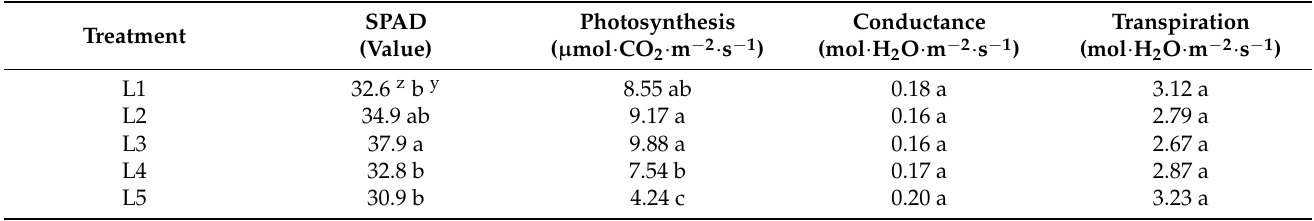
Table 5. Effect of light intensity on photosynthesis rate, stomatal conductance, transpiration rate and SPAD apple seedlings at 30 days after treatment. L1, L2, L3, L4 and L5 indicate light intensity (Table 3).